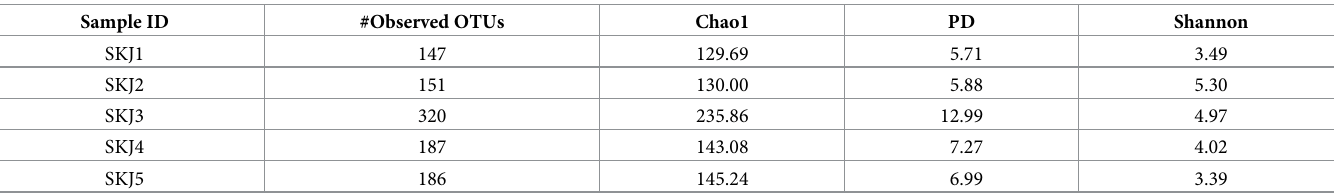
Table 4. Gut microbiota alpha diversity